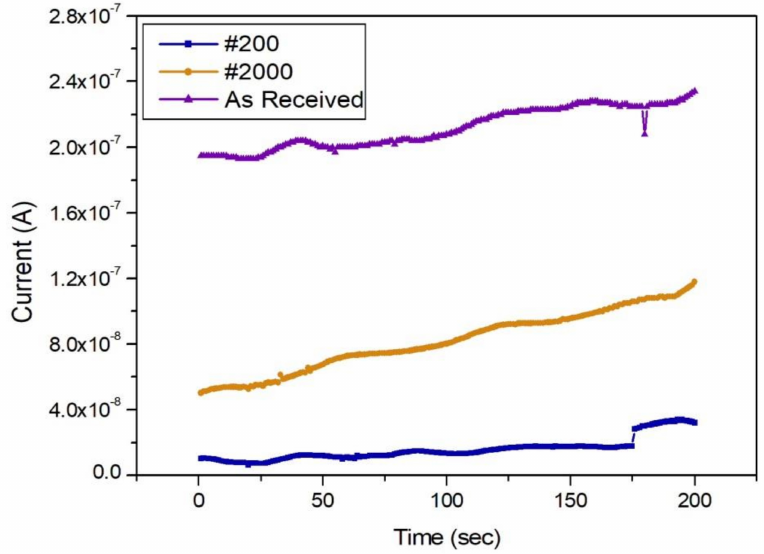
Figure 5. Graph of galvanic corrosion results at all SPCC surface conditions for as-received CFRP.